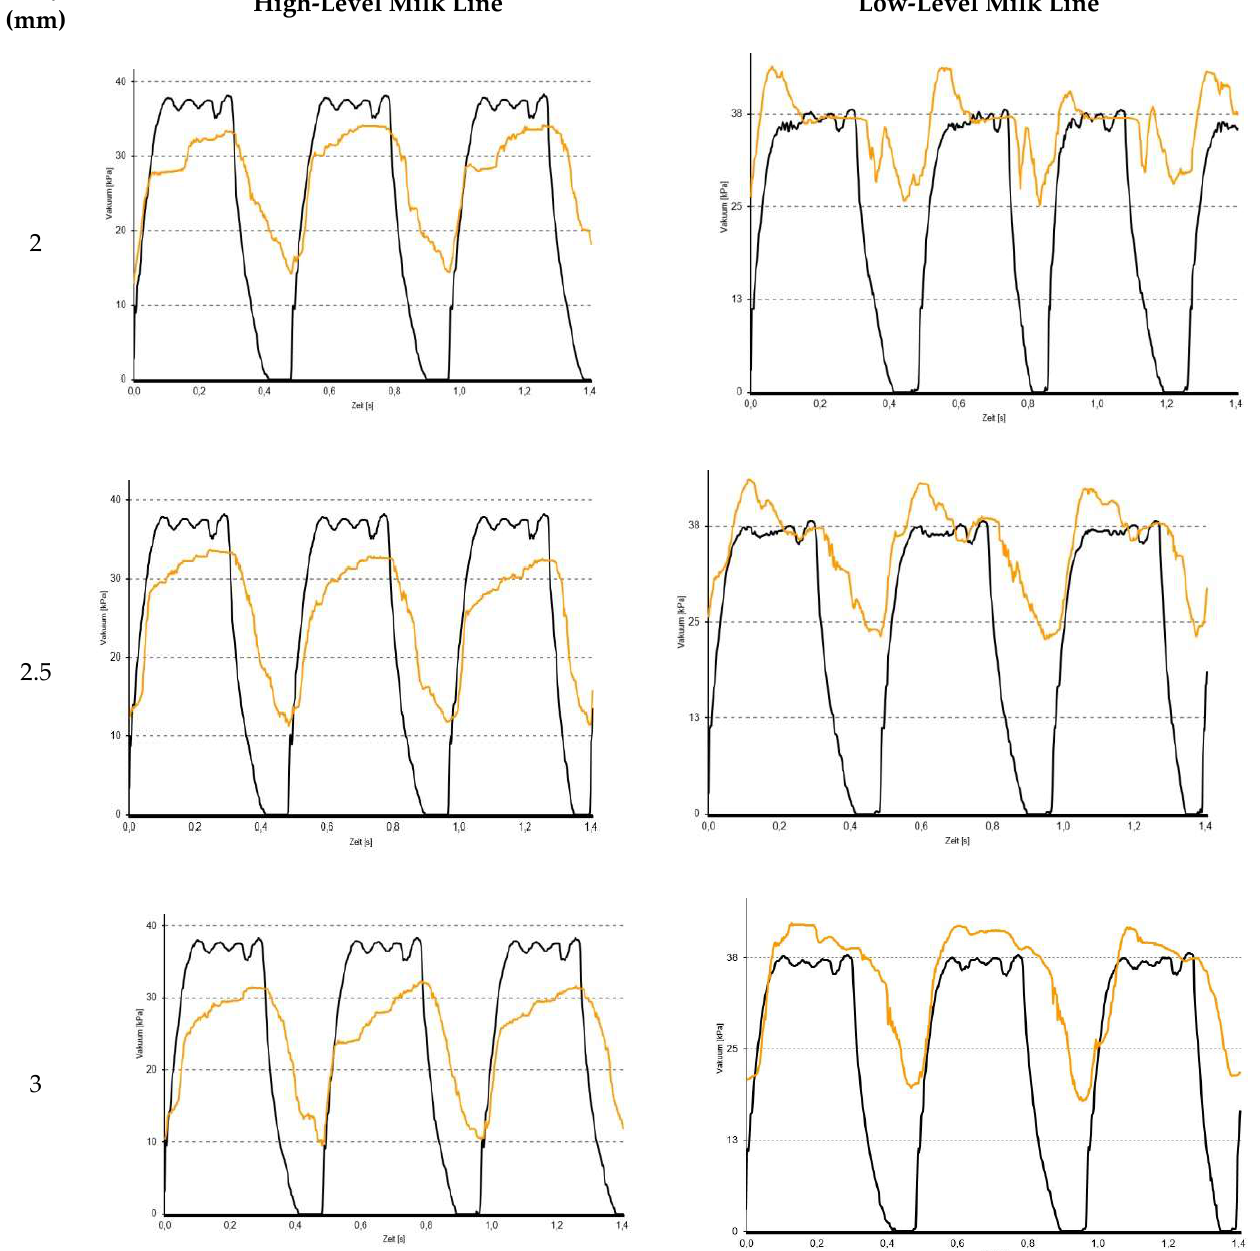
Figure 3. Cyclical vacuum fluctuations in the pulsation and inner chambers of the teat cup during milking the 1st WF in the sheep milking machine with the following settings: 38 vacuum level (kPa), 120 pulsation rate (cycles/min) and 60:40 pulsation ratio.